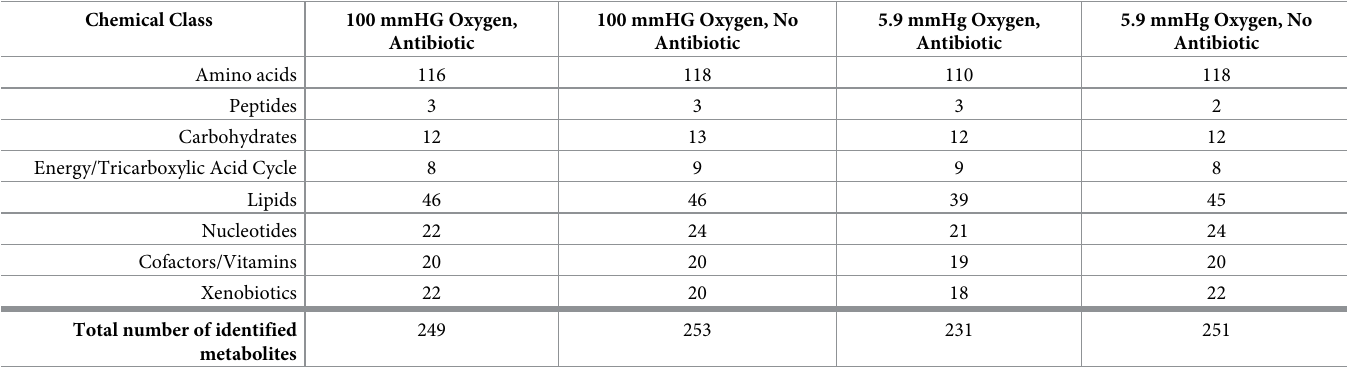
Table 1. Number of identified metabolites from tissue culture supernatants across oxygen and antibiotic treatments, organized by chemical class. Chemical